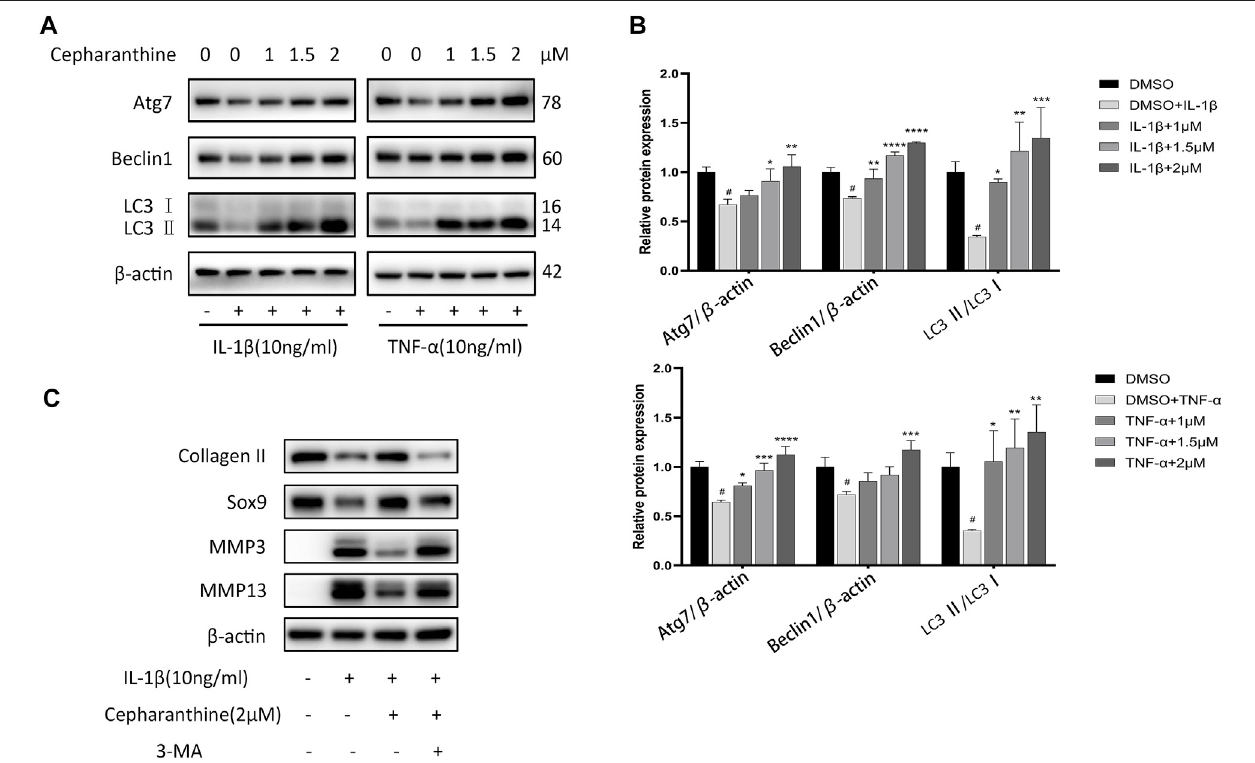
FIGURE4| CEPattenuateddownregulationofautophagyinchondrocytes. (A,B) WesternblotresultsandquantitativeanalysisshowedthelevelsofAtg7,beclin1, and LC3 II/LC3 I ratio in chondrocytes stimulated with IL-1 β or TNF- α for 24 h after CEP pretreatment. (C) Western blotting of collagen II, Sox9, MMP3, and MMP13 in chondrocytespretreatedwithorwithout3-MA(5 mM)beforetreatmentwithCEP(2 μ M)orIL-1 β .Valuesareexpressedasmean±SD, n =3;# p < 0.05vs.controlgroup, * p < 0.05, ** p < 0.01, *** p < 0.001, and **** p < 0.0001 vs. model group.